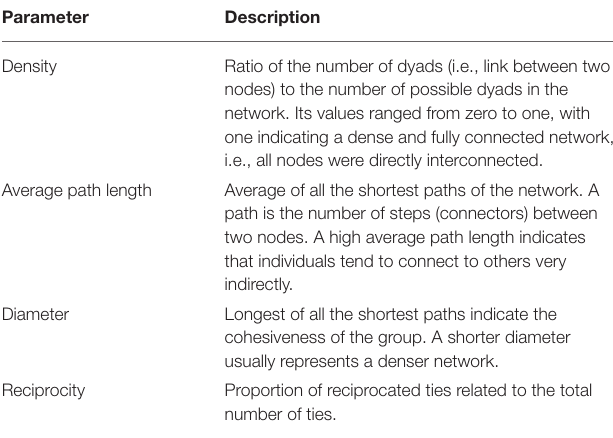
TABLE 1 | Main network descriptive metrics